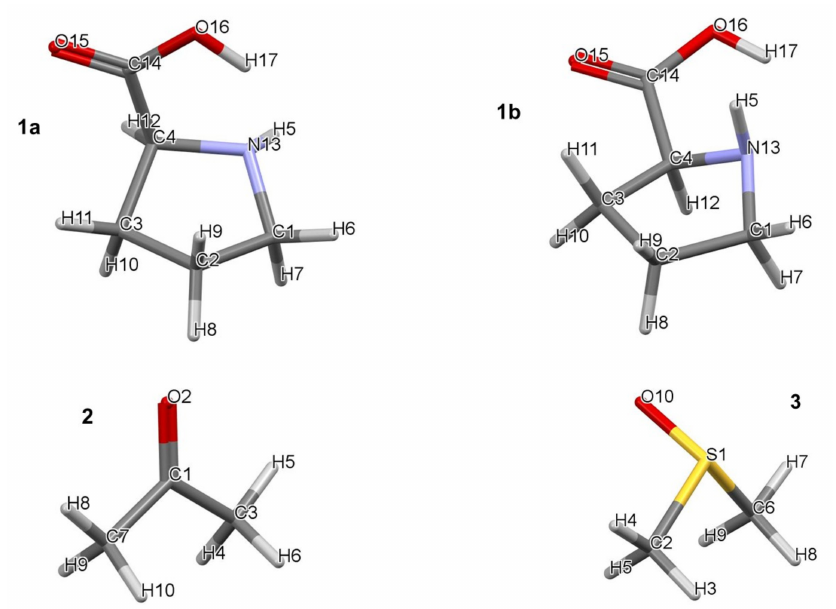
Figure 1. Numbering of atoms in lowest ( 1a ) and higher ( 1b ) energy conformers of proline ( 1 ), acetone ( 2 ), and DMSO ( 3